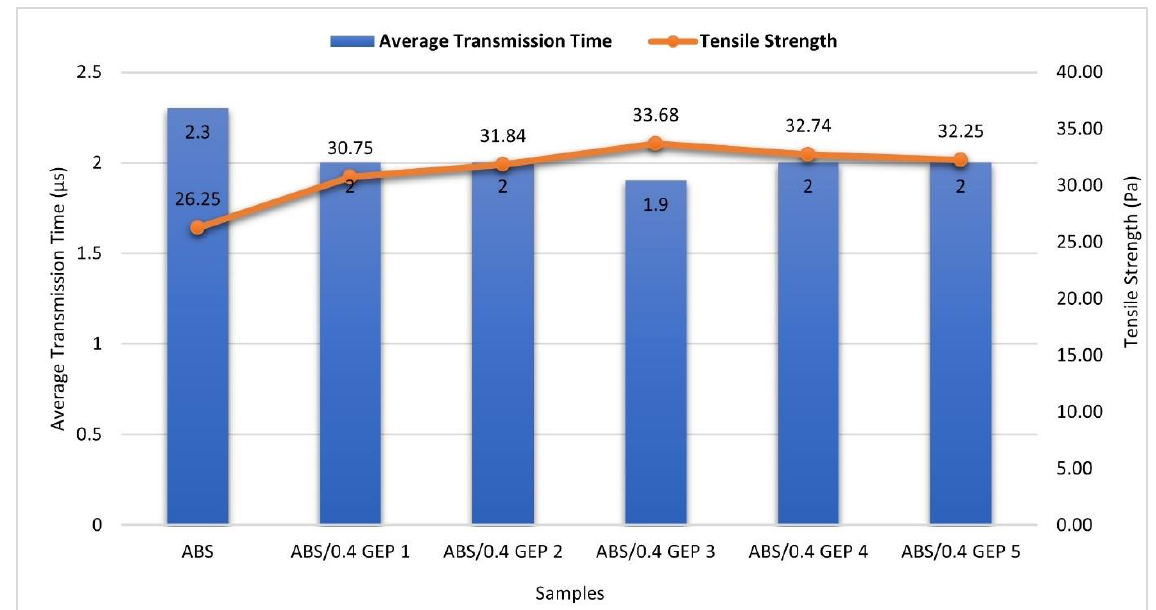
Figure 16. Correlation between average transmission times and tensile strength for ABS/0.4 GEP composites.